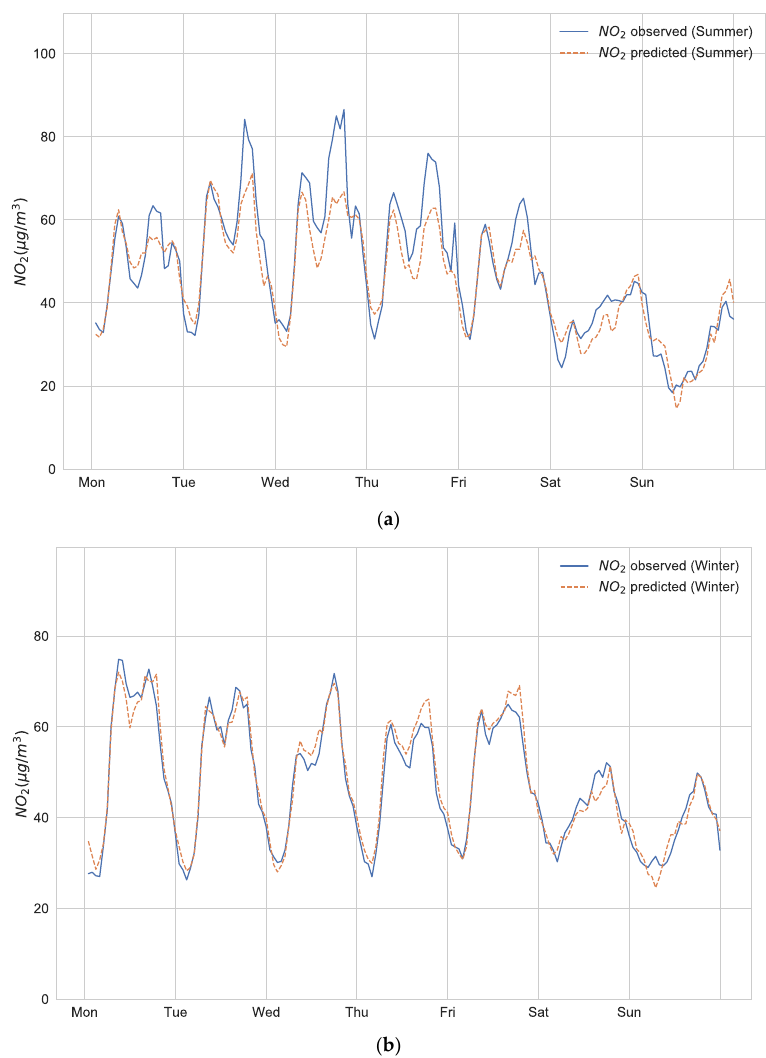
Figure 5. The average weekly pattern of observed NO 2 and predicted NO 2 values with a bootstrapped 95% confidence interval in ( a ) summer and ( b ) winter.